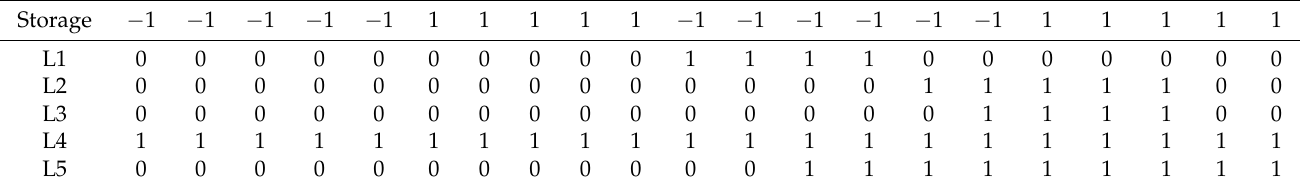
Table 9. Optimal status of battery storage and adjustable loads over 24 h of